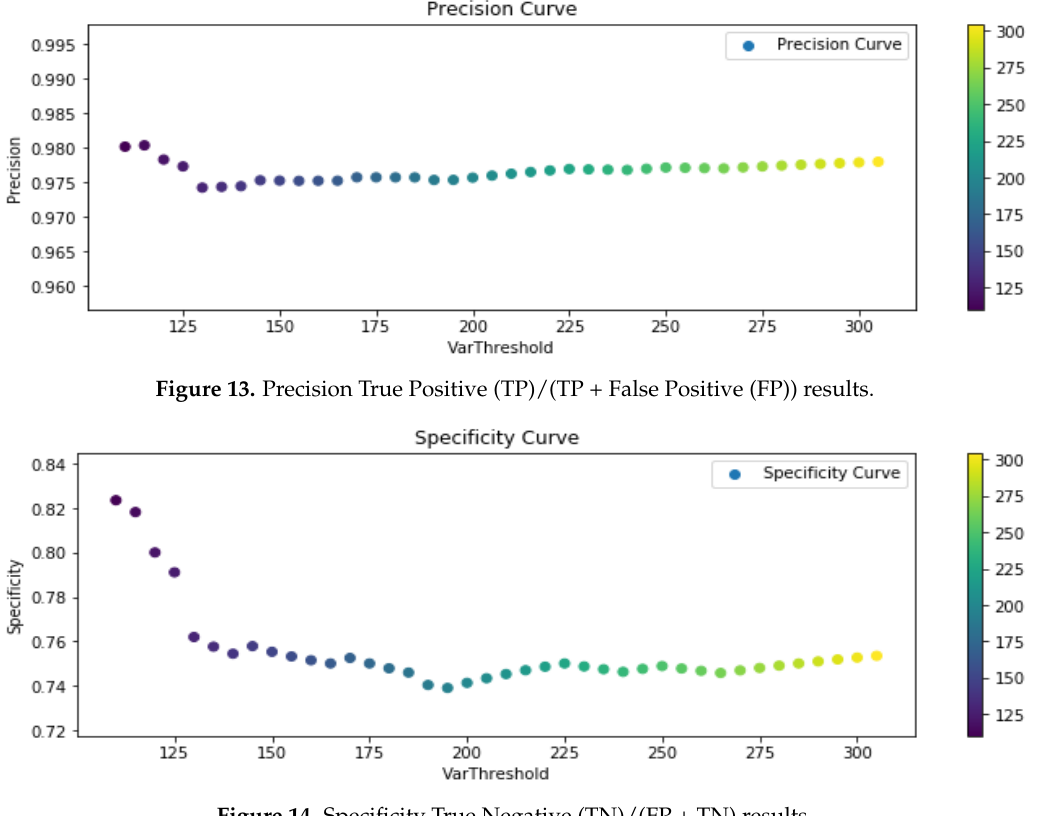
Figure 14. Specificity True Negative (TN)/(FP + TN)